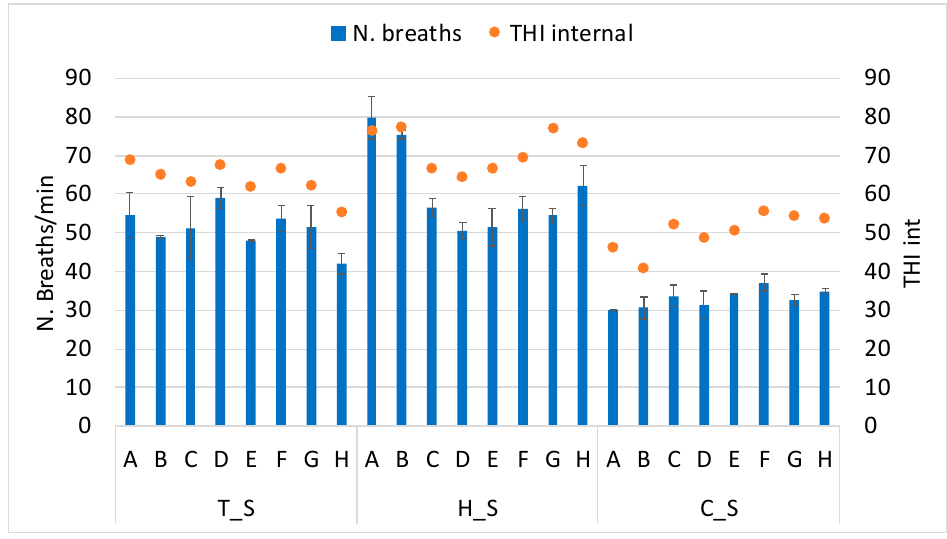
Figure 6. Relation between THI internal in the barn and the respiration rate (number of breaths/min) during the three periods (thermoneutral = T_S, hot = H_S and cold = C_S) in each sampled farm (A to H). Vertical bars express the standard deviation.